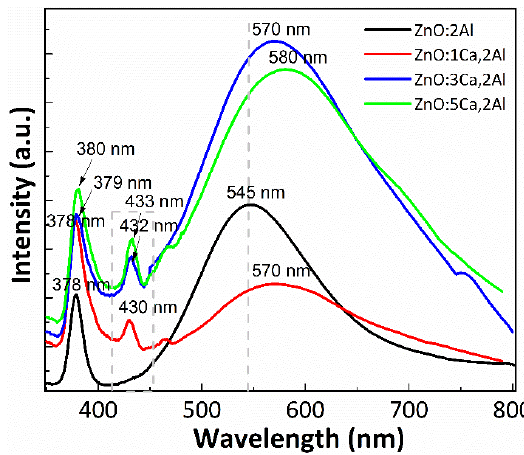
Figure 4. PL Emission spectra of ZnO:Al 2% and Ca-doped ZnO:Al 2% thin films with: 1, 3 and 5% Ca.